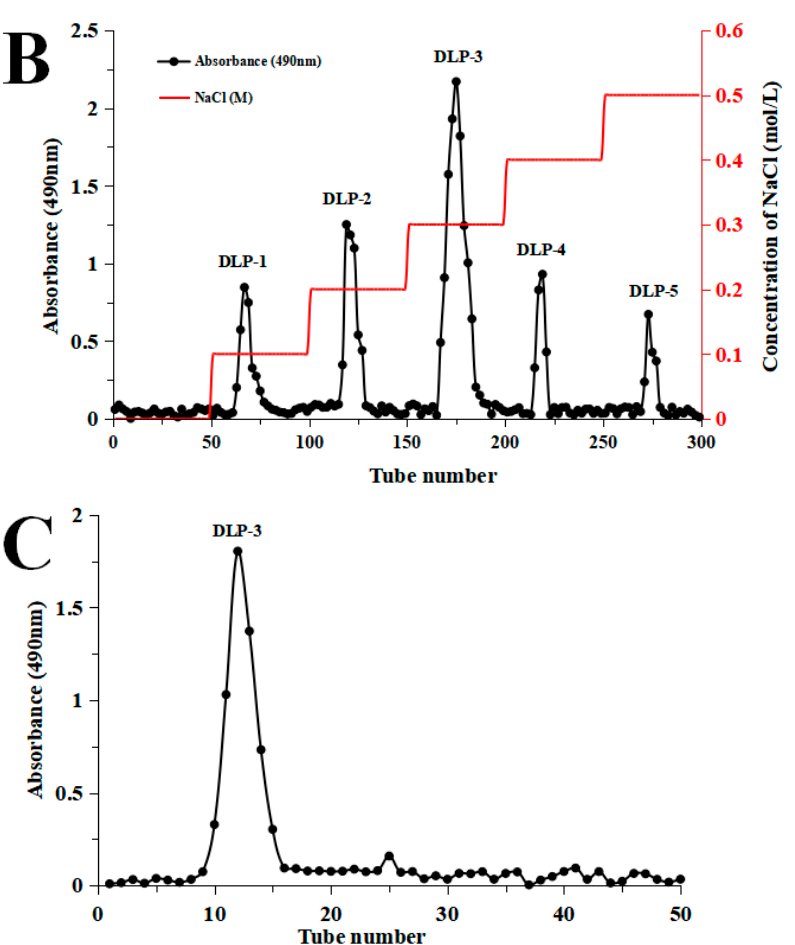
Figure 1. ( A ) Flow chart of extraction and purification of DLP-3; ( B ) chromatography of DLP-3 using